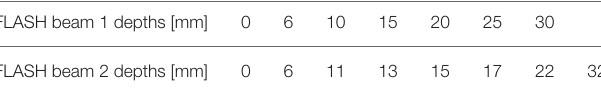
TABLE 1 | Film positions at different depth for the two FLASH